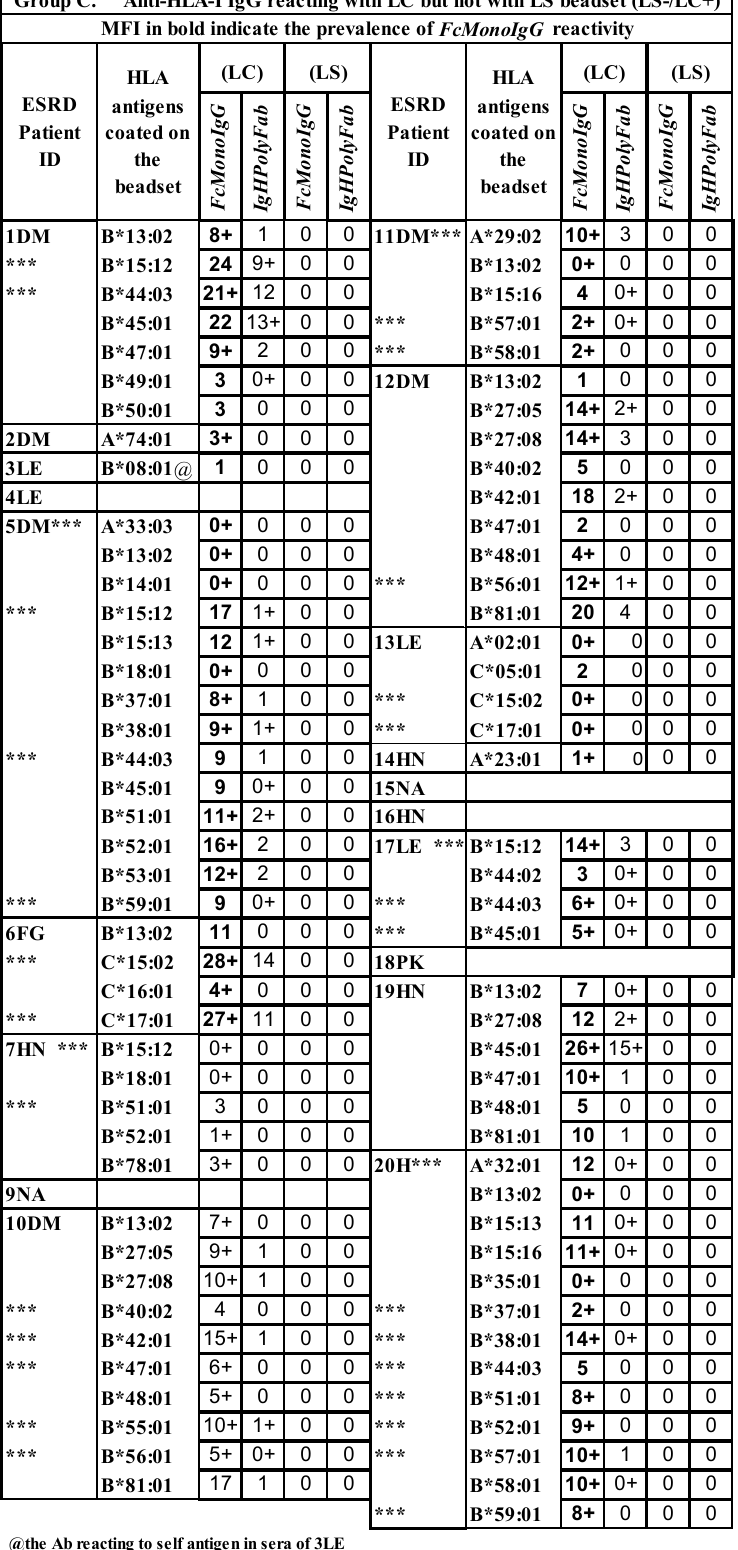
Figure 2. Three groups of serum IgG antibodies in ESRD patients reacting to HLA-I antigens on either LS or LC, or to both SABs, when tested with two different detection Abs ( FcMonoIgG and IgHPolyFab ). MFI values are expressed as thousands. Group A: Abs binding to both SABs; Group B: Abs binding to LS-SAB only; Group C: Abs binding to LC-SAB only. IgG